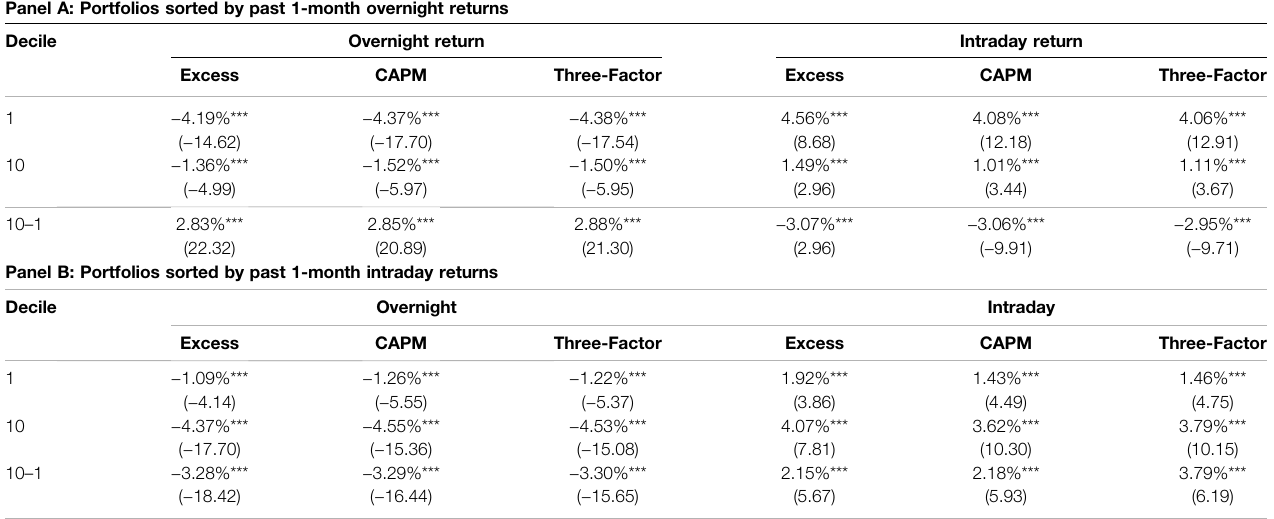
TABLE 3 | Persistence of overnight/intraday return for A-shares stocks Panel A: Portfolios sorted by past 1-month overnight returns